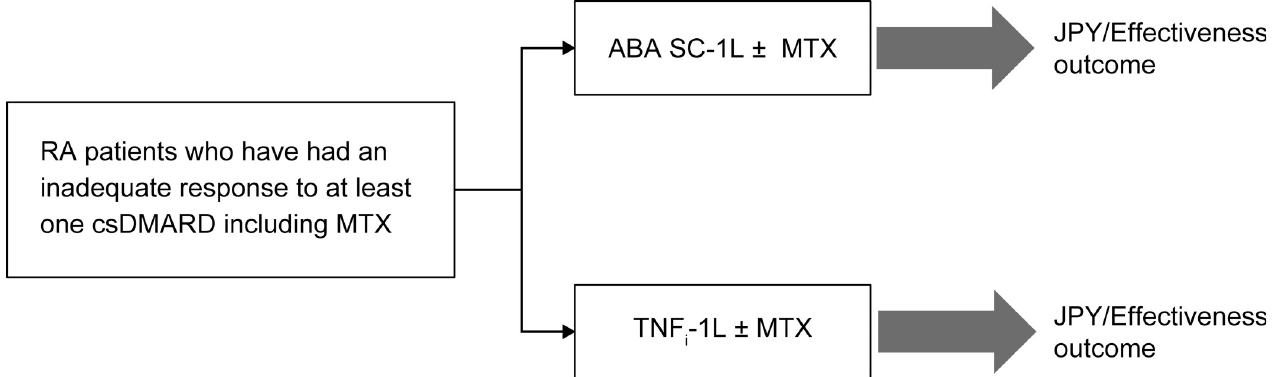
Fig 1. Decision tree structure (ABA-1L vs. TNFi-1L). The target population was RA patients who had an inadequate response to prior treatment with at least one csDMARD, including MTX, in clinical practice. The cost-effectiveness was compared between ABA SC-1L ± MTX and TNFi-1L ± MTX. 1L, first line; ABA, abatacept; csDMARD, conventional synthetic disease-modifying antirheumatic drug; JPY, Japanese Yen; MTX, methotrexate; RA, rheumatoid arthritis; SC, subcutaneous; TNFi, tumour necrosis factor inhibitor.